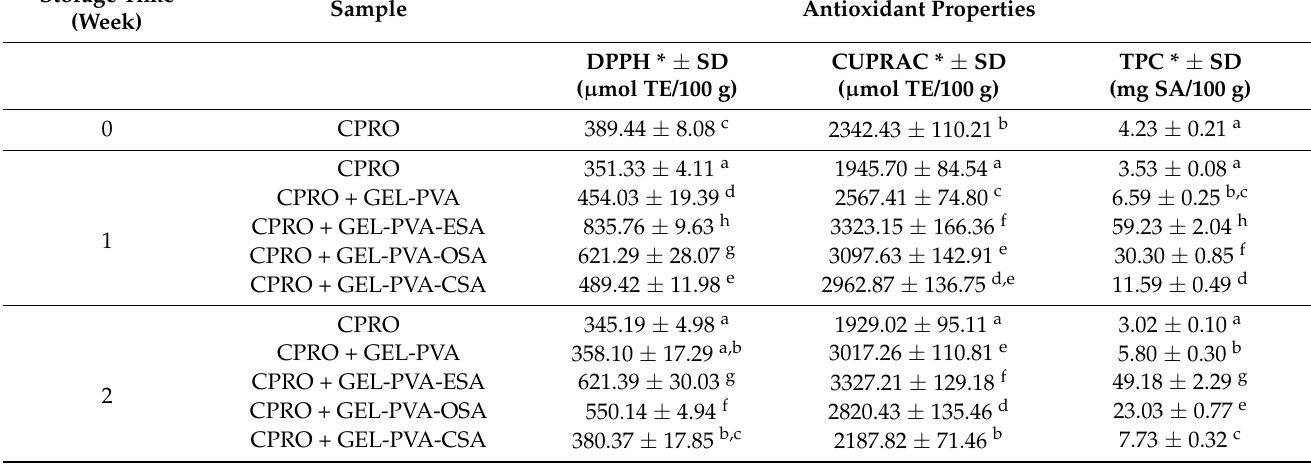
Table 2. Changes in the antioxidant properties of cold-pressed rapeseed oil without and with GEL- PVA film strips loaded with sinapic acid esters during storage for two weeks at accelerated conditions (T = 40 ◦ C, fluorescent